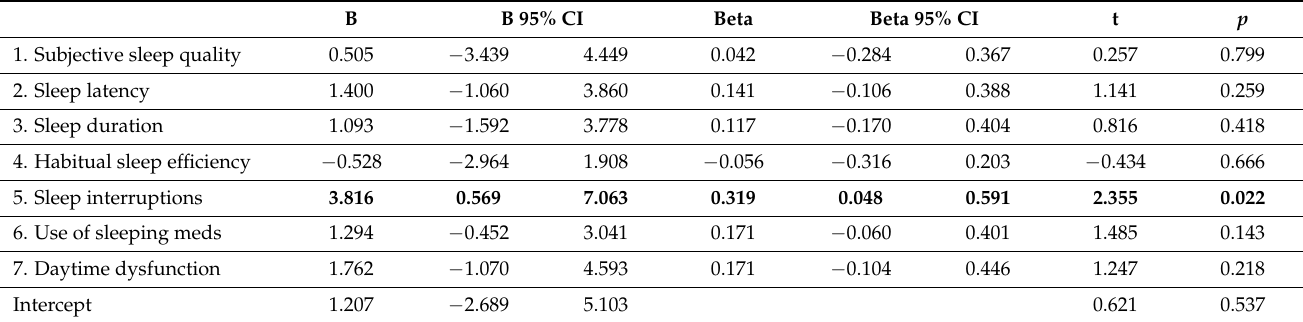
Table 6. Model 2, including PSQI components